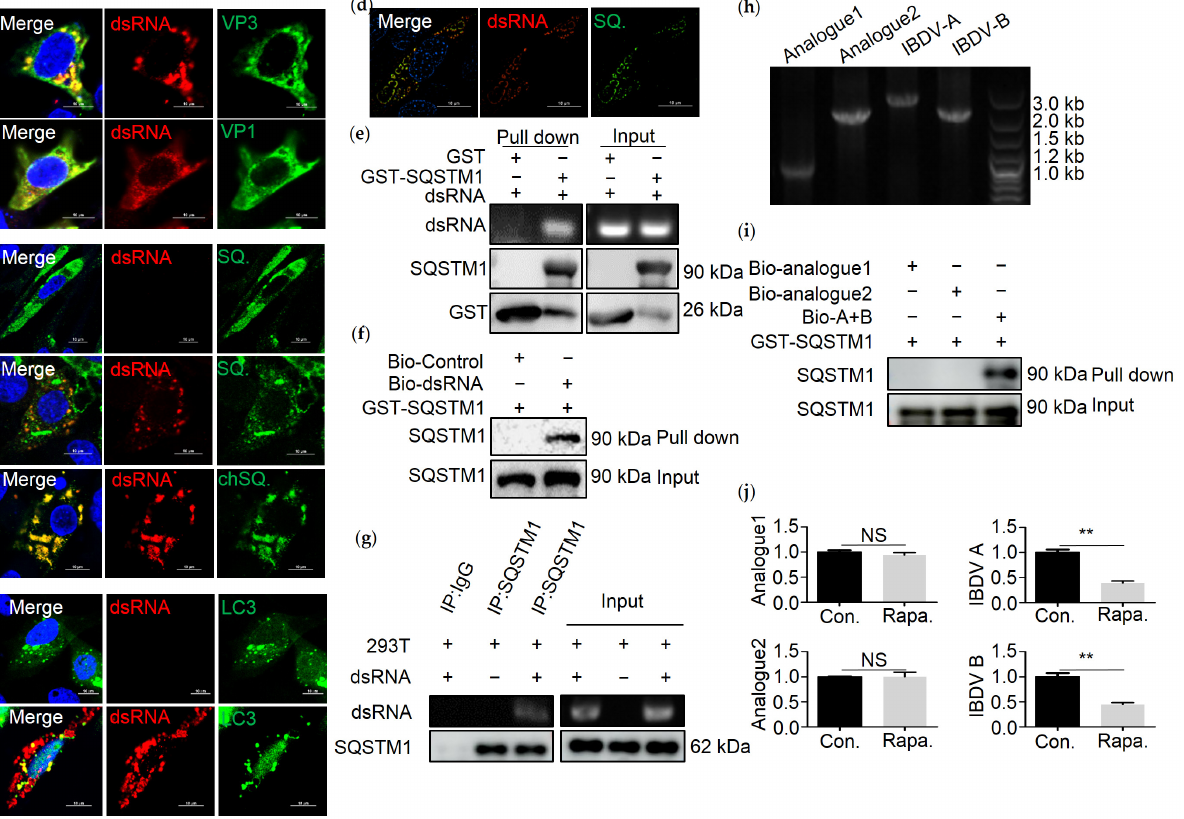
Figure 3. SQSTM1 interacts with dsRNA. ( a ) DF-1 cells were infected with IBDV at MOI = 0.1 for 18 h, followed by confocal analysis of DF-1 cells infected with IBDV by using anti-dsRNA, -VP3, -VP1 antibodies. Scale bar = 10 µm. ( b ) DF-1 cells transfected with Myc-human SQSTM1 (SQ.) or Myc-chicken SQSTM1 (chSQ.) for 18 h, and infected with IBDV at MOI = 0.1 for 18 h (uninfected sample used as control), followed by confocal analysis of DF-1 cells infected with IBDV by using anti-dsRNA and -Myc antibodies. Scale bar = 10 µm. ( c ) DF-1 cells transfected with GFP - LC3 (LC3) for 18 h and infected with IBDV at MOI = 0.1 for 18 h (uninfected sample used as control), followed by confocal analysis of DF-1 cells infected with IBDV by using anti-dsRNA antibodies. Scale bar = 10 µm. ( d ) DF-1 cells transfected with Myc-SQSTM1 for 18 h and infected with IBDV at MOI = 0.1 for 18 h, followed by SIM analysis using anti-dsRNA and -Myc antibodies. Scale bar = 10 µm. ( e ) Prokaryotically expressed protein GST-SQSTM1 binds to IBDV dsRNA. GST-SQSTM1 was incubated with IBDV dsRNA for 4 h, and an RNA binding protein immunoprecipitation assay was performed using anti-GST resin. Purified IBDV dsRNA was pulled down by the GST-SQSTM1 protein but not by the GST tag protein. ( f ) GST pull-down shows that SQSTM1 directly interacts with dsRNA. IBDV dsRNA was labeled with biotin by using a kit. Only the purified IBDV dsRNA can bind to SQSTM1 directly. An RNA pull-down assay was conducted to confirm the interaction between SQSTM1 and dsRNA. ( g ) Endogenous SQSTM1 binds to IBDV dsRNA. 293T cells were incubated with IBDV dsRNA for 4 h. Anti-SQSTM1 precipitation was performed, and IBDV dsRNA was precipitated by endogenous SQSTM1. ( h ) DsRNA nucleic acid analogs were separated by agarose gel electrophoresis, including analog 1(1 kb), analog 2(2.8 kb), IBDV A(3.2 kb), and IBDV B(2.8 kb). ( i ) Prokaryotically expressed protein GST-SQSTM1 interacts with IBDV A and B but not any other dsRNA analogs. DsRNA analogs were labeled with biotin, and a pull-down assay was performed. An immunoblotting analysis using anti-SQSTM1 antibodies was performed. ( j ) QRT-PCR analysis of dsRNA analogs from 293T cells trans- fected with dsRNA analogs for 8 h and treated with Rapa (5 µM) for 4 h before collection. Data were represented as mean ± SD of three independent experiments. NS, not significant ( p > 0.05); ** p < 0.01. 3.4. SQSTM1 Inhibits IBDV Replication Since SQSTM1 bound to dsRNA directly and promoted the degradation of IBDV dsRNA, we next examined whether SQSTM1 affects IBDV replication. We analyzed the genome level, viral protein VP2, and titer of IBDV in SQSTM1-overexpressing or knockout cell lines infected with IBDV. As shown in Figure 4a, the viral VP2 protein level decreased greatly in 293T cells stably expressing SQSTM1. TCID 50 and qRT-PCR assays also con- firmed that virus titer and genomic copies decreased significantly upon stable expression